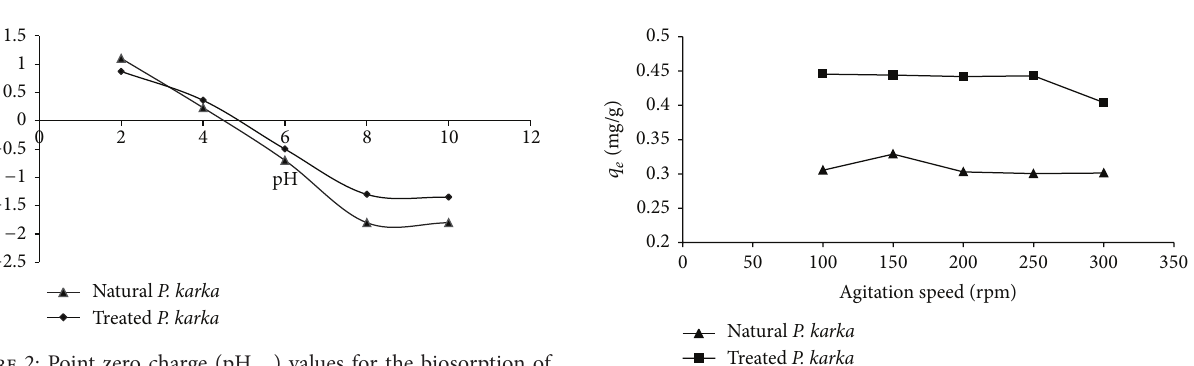
Figure 2: Point zero charge (pH pzc ) values for the biosorption of mercury ions on natural P. karka and treated P. karka (concentration = 10mg/L, time = 30 minutes, 𝑇 = 298 K, agitation speed = 150 rpm, dose of biosorbent = 2g/100 mL, and pH = 2–8).